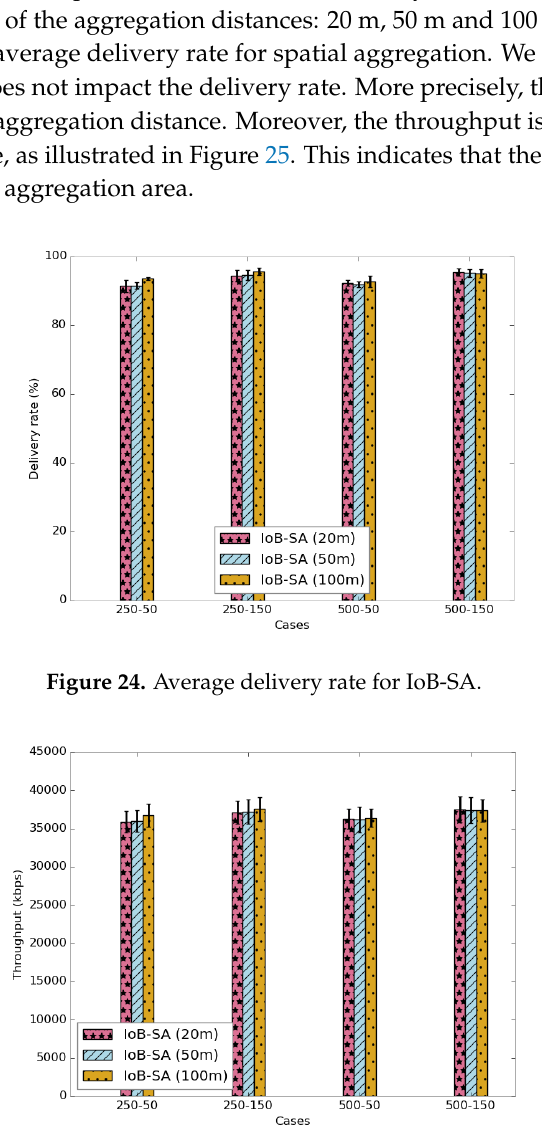
Figure 25. Average throughput for